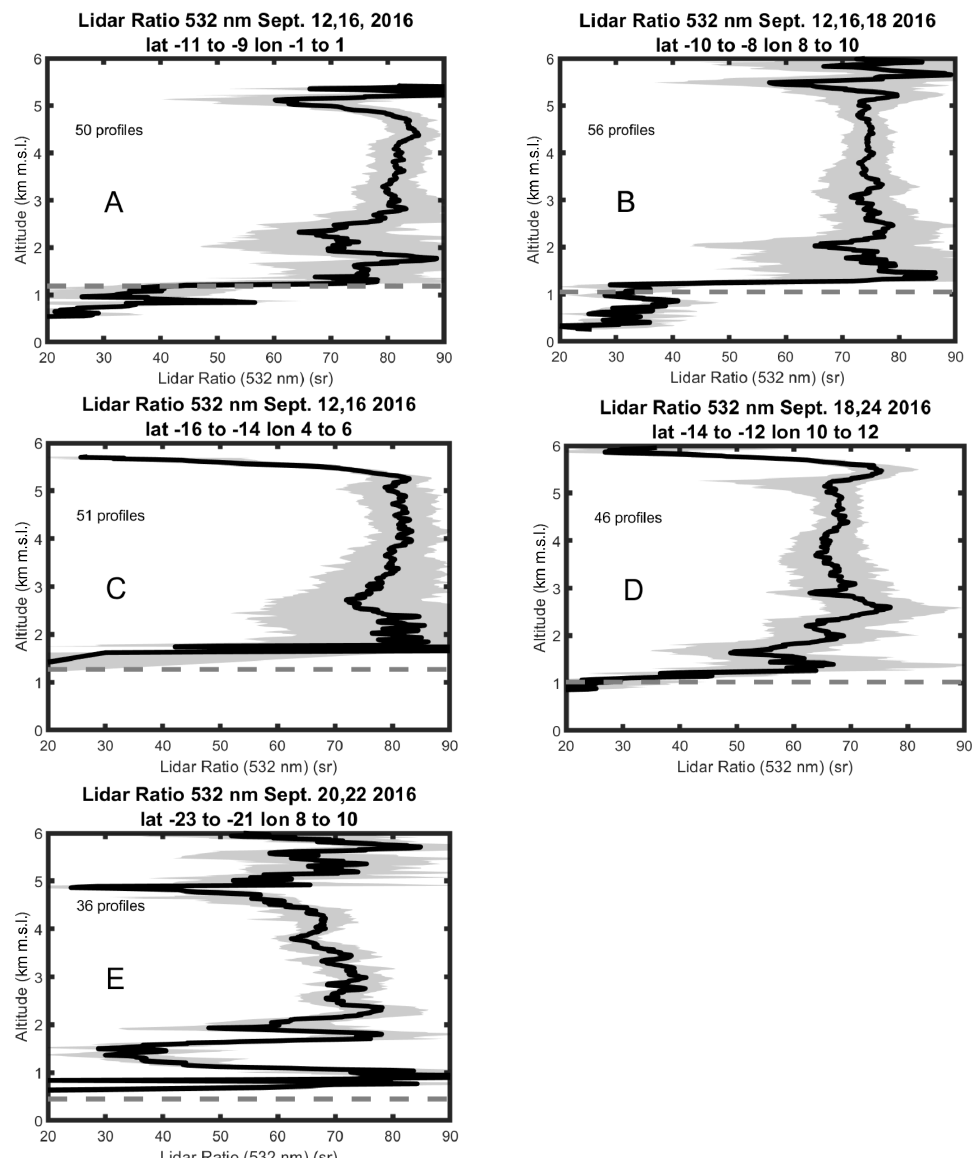
Figure 9. As in Fig. 6 but for the lidar ratio at